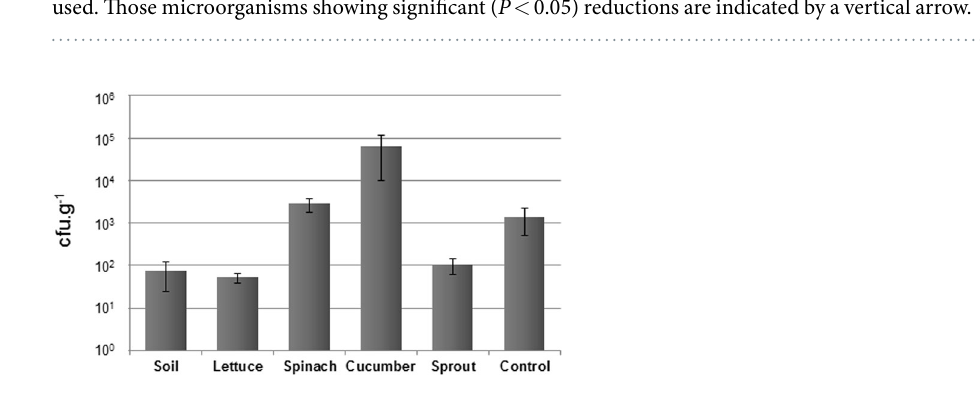
where they can persist for a certain length of time and maintain the capacity to propagate, the transduction of stx to the background flora could, under the right conditions, take place. This should be a rare occurrence, and fortunately the high densities of host bacteria and Stx phages required for stx transduction in food matrices shown in previous studies 28 , are not commonly found in food samples. Nevertheless, as demonstrated in our model, there was no restriction on transduction in the matrices analyzed, and new STEC could be generated, in accordance with previous studies on soil 55 , salads 28 , and biofilms 56 . Given that three of our matrices are consumed raw (lettuce, sprouts, and cucumber), and even spinach may be included as a salad ingredient, the low number of transductants generated would be sufficient to pose a health problem. The outbreak of E . coli O104:H4 in Europe 22 , in addition to the human casualties and health-associated costs, indicates that accidental STEC contamination or emergence due to Stx phage transduction events could unfor- tunately become a common occurrence. Protecting vegetables against possible deliberate, accidental, or natural microbial contamination is imperative to ensure a safe food chain. Methods to reduce microbial risks in the veg- etable food chain should not neglect Stx phage elimination.